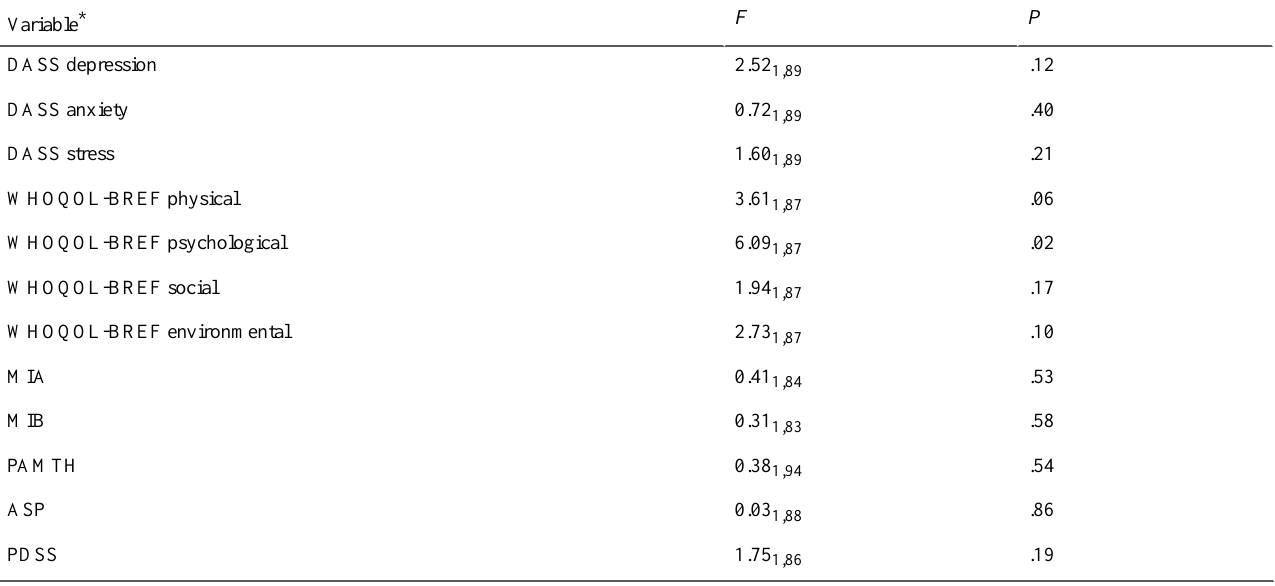
Table 5. F ratios and P values from pretreatment assessment